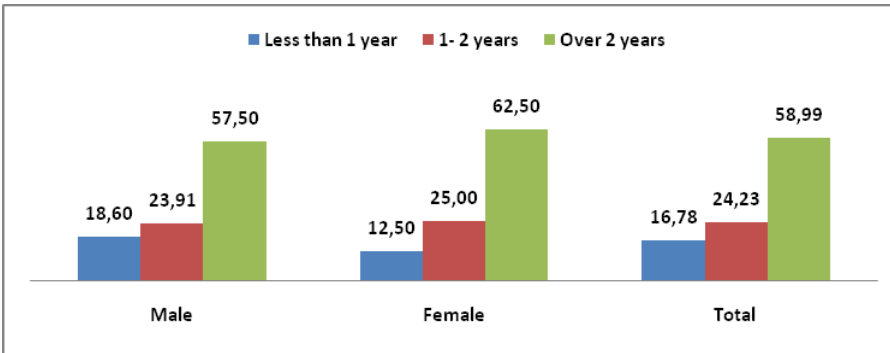
Figure 7: Percentage distribution of young people by time to first job and gender